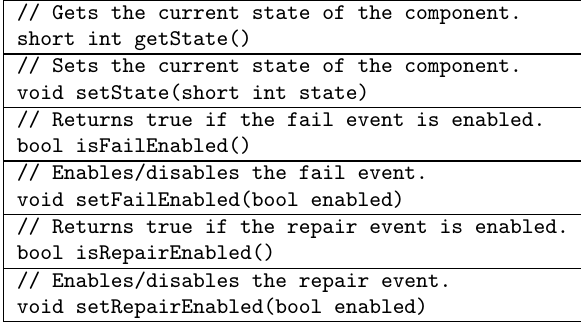
Table 1: Useful member functions for Component class.